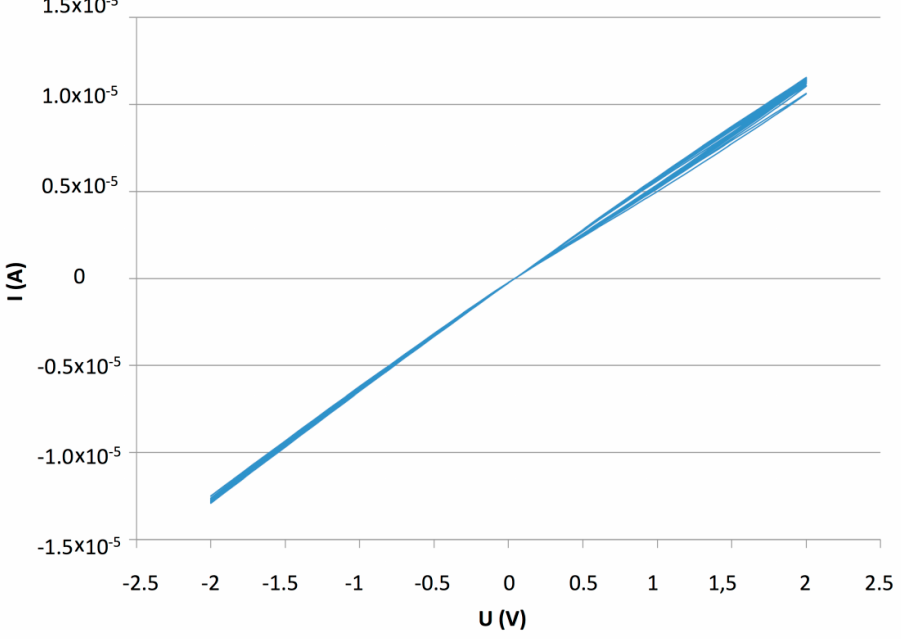
device (E5) at 30, 20